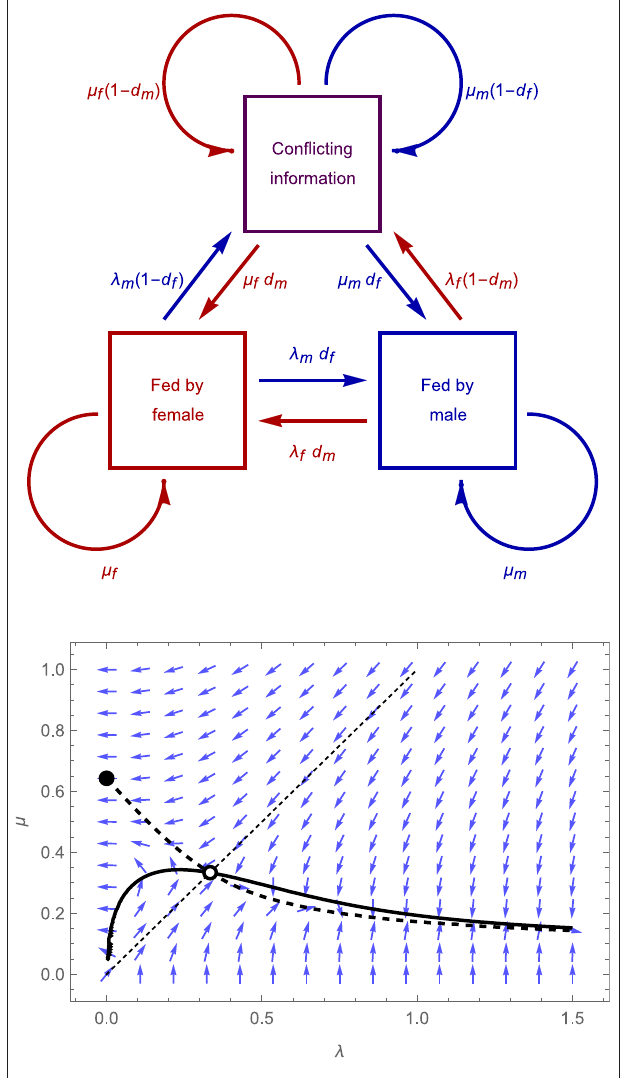
FIGURE 2 | Structure of the “imperfect monitoring” model described in the main text, which incorporates the possibility that either parent may fail to detect visits by the other (upper panel), and adaptive dynamics for an illustrative case (lower panel) in which λ f = λ m = λ , µ f = µ m = µ , d f = d m = 0.8 (with payoffs as specified in the legend to Figure 1 ). Blue arrows show the direction of the selection gradient for a population characterized by particular values of λ and µ , thick curves represent the null-clines for λ (solid curve) and µ (dashed curves), while empty and filled circles denote convergently unstable and stable equilibria,